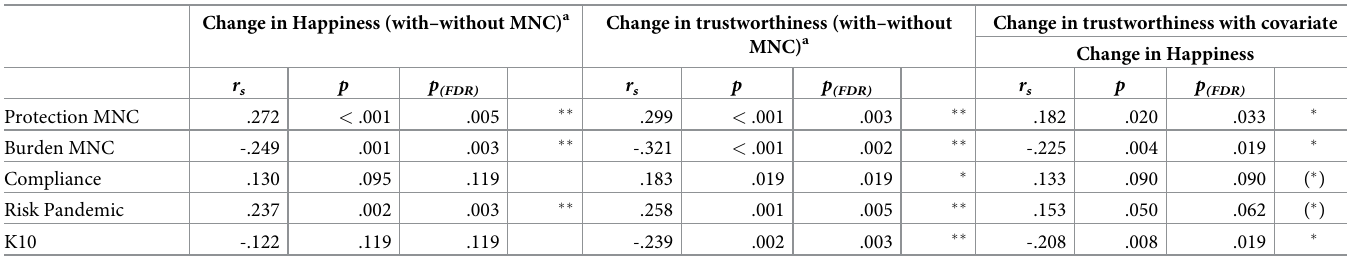
Note . a smaller scores indicate a more negative appraisal of faces with an MNC. � p < 0.05, �� p <